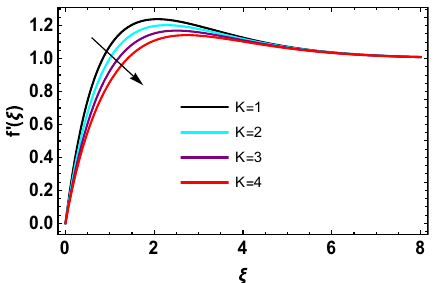
Figure 3. Impact of K upon f ′ (ξ) .